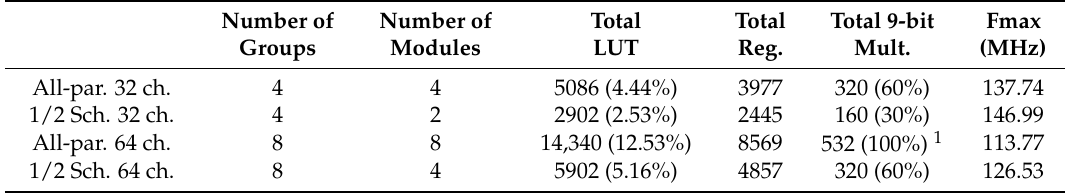
Table 3. Resource consumption and max frequency of all parallel and 1/2 scheduling for 32-channel and 64-channel architectures. Number of Number of Groups